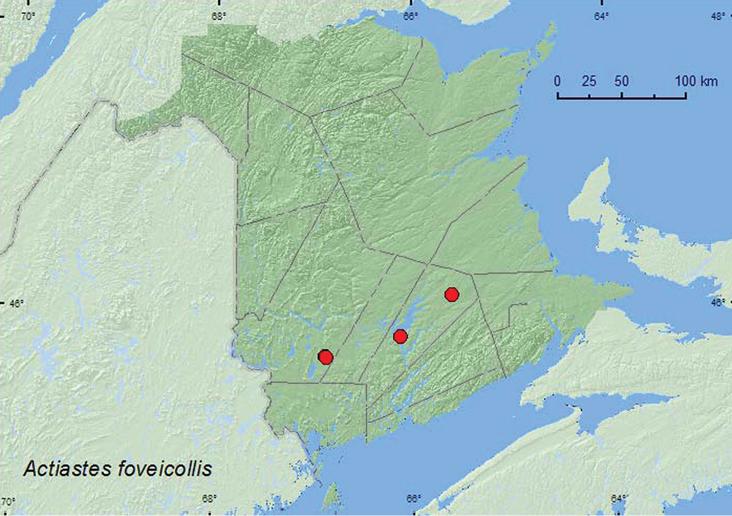
Collection localities in New Brunswick, Canada of Actiastes foveicollis.